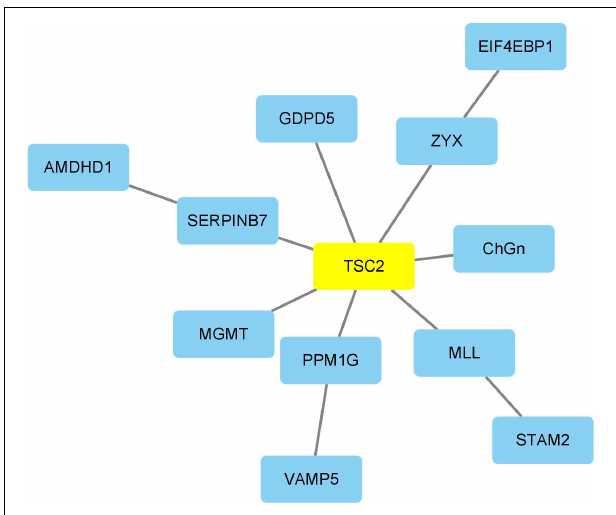
FIGURE 7 | The network marker with the highest betweenness of